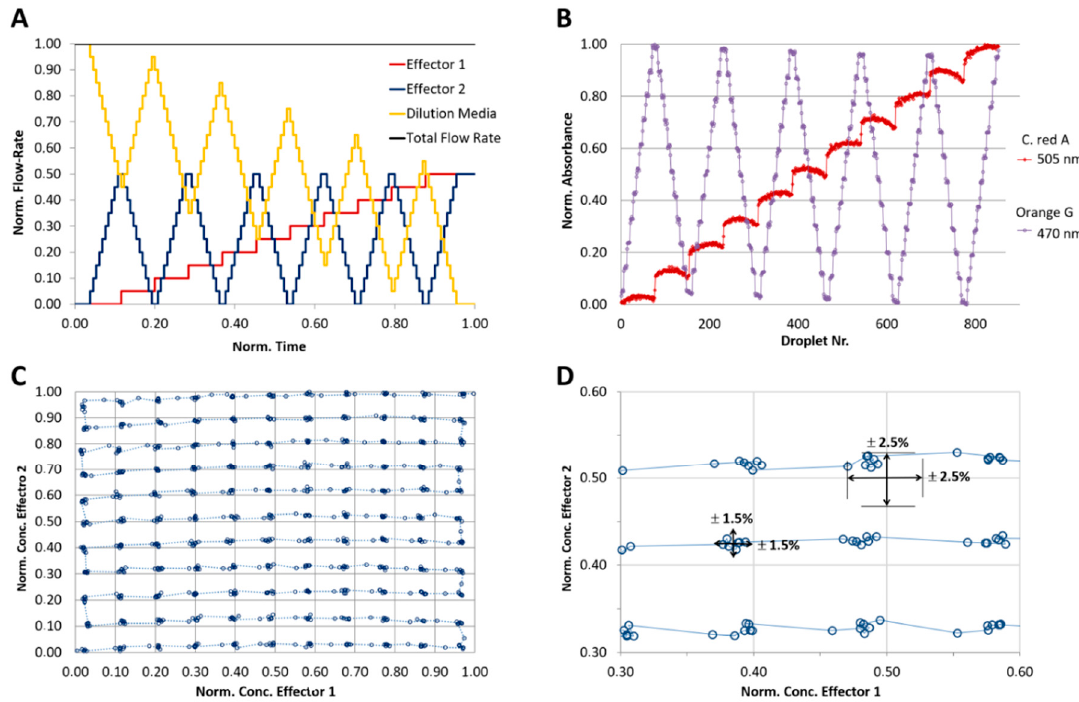
Figure 9. Analysis of the droplet composition accuracy regarding to the desired programmed composition. Two-dimensional program with stepwise varied compositions of two reporter dyes (C. red A and Orange G) A sequence of about 800 droplets was analyzed by two wavelength photometry. Absorbance of the two dyes (505 and 470 nm) were detected independently. ( A ) Syringe pump